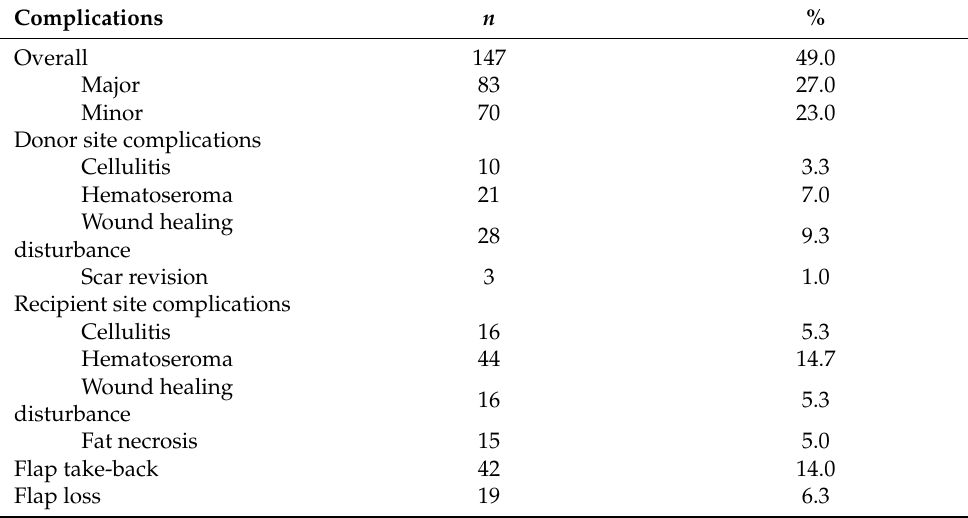
Table 4. Complications overview; donor site, recipient